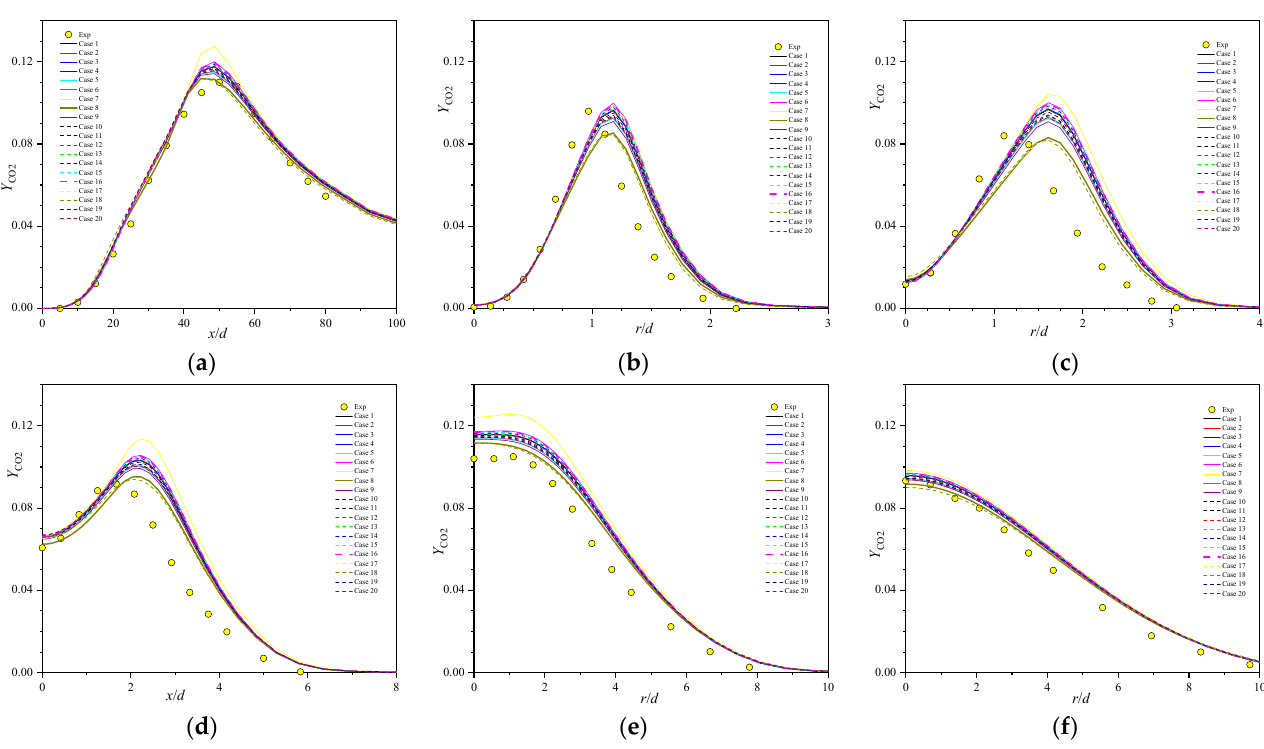
Figure 7. Comparison of measured [22,24] and predicted mean CO 2 mass fraction profiles for the Sandia Flame D with 20 combinations of the primary EDC constants C D1 and C D2 . ( a ) @axis. ( b ) @ x / d = 7.5. ( c ) @ x / d = 15. ( d ) @ x / d = 30. ( e ) @ x / d = 45. ( f ) @ x / d = 60. The predicted peaks of the mean mass fractions of CO 2 are decreased with the mod- ified EDC constants and the largest is attributed to case 8, as expected. The axial profiles of the mean mass fractions of CO 2 , as shown in Figure 7, agree better with the experiments Fig_S5 in [42]) from local modification of EDC constants for flame D show that the peaks larger than that of the actual peak of mass fraction of CO 2 is improved slightly.